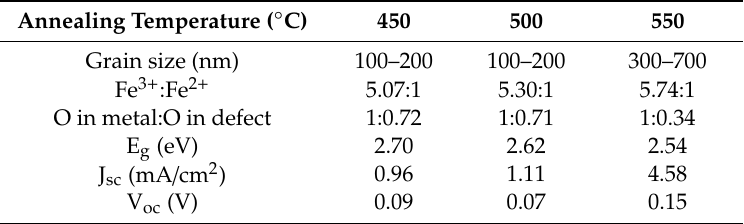
Table 1. The grain size, Fe 3 + / Fe 2 + ratio, O in metal / O in defect ratio, band gap (E g ), short circuit photocurrent density (J sc ) and the open circuit photovoltage (V oc ) of BFO thin films annealed at di ff erent